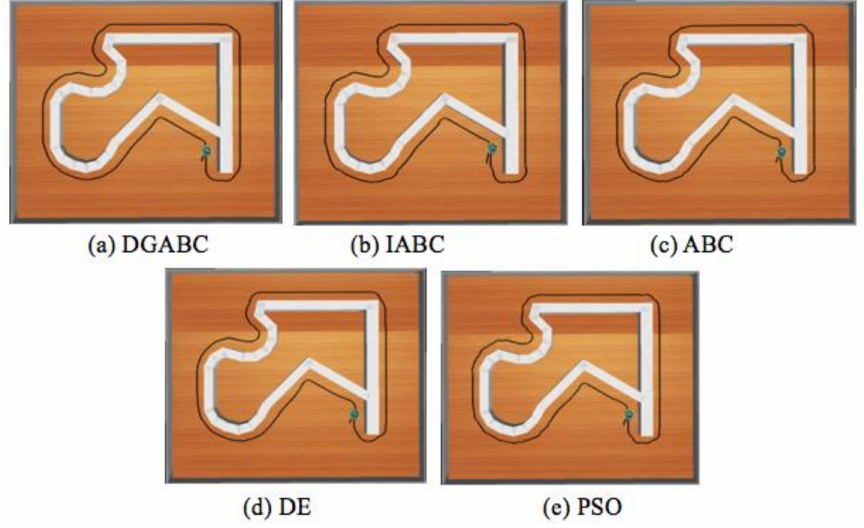
Figure 23. Moving path of various algorithms in the training environment.